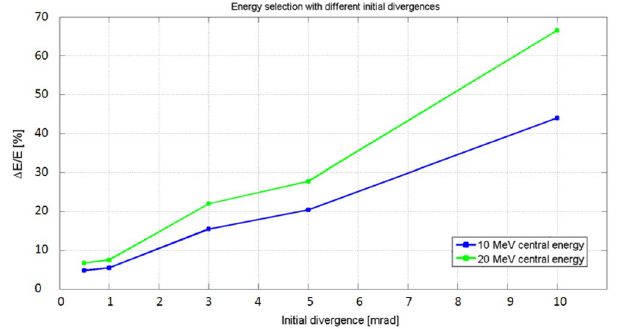
Figure 4. Final energy spread the selected beam as a function of the initial divergence of the protons, for the cases of a mean energy of 10 and 20 MeV. The cases of 0.5, 1, 3, 5 and 10 mrad have been analyzed with TSTEP simulations. The green and blue curve have been obtained by interpolating the values of the final energy spread as obtained by the